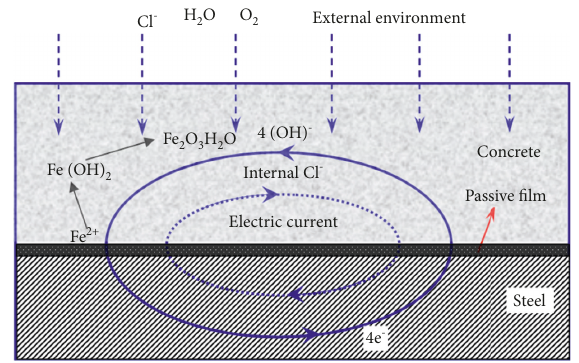
Figure 1: The failure mechanism of chloride ion on reinforced concrete